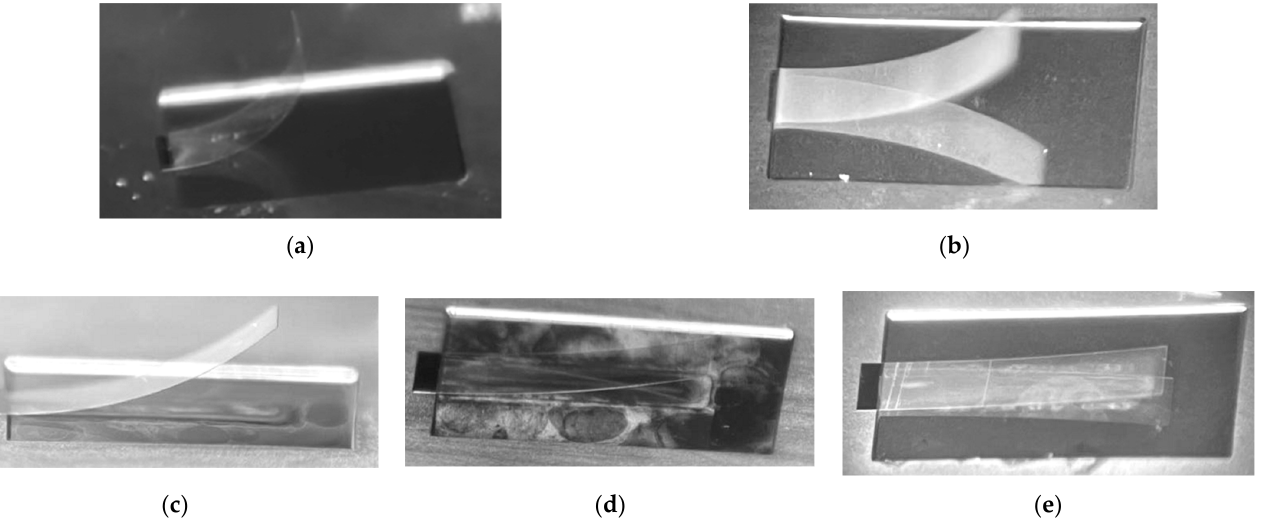
Figure 6. The Physical image of a cantilever beam with different SiO 2 /SiN x